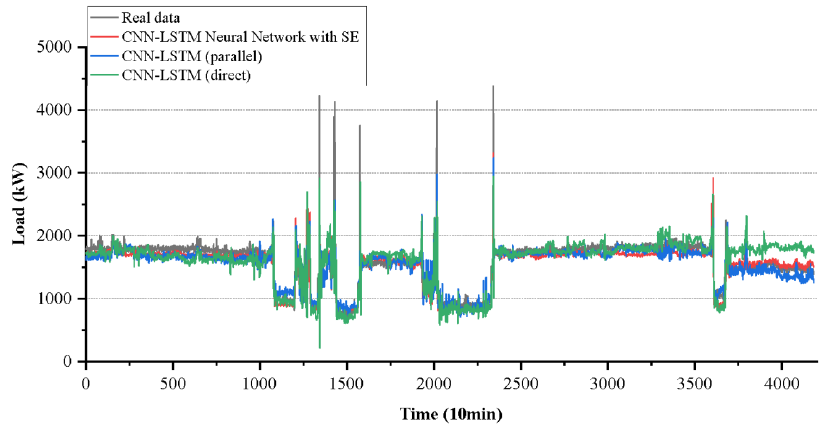
Figure 8. Comparison of models through forecasting with real data.